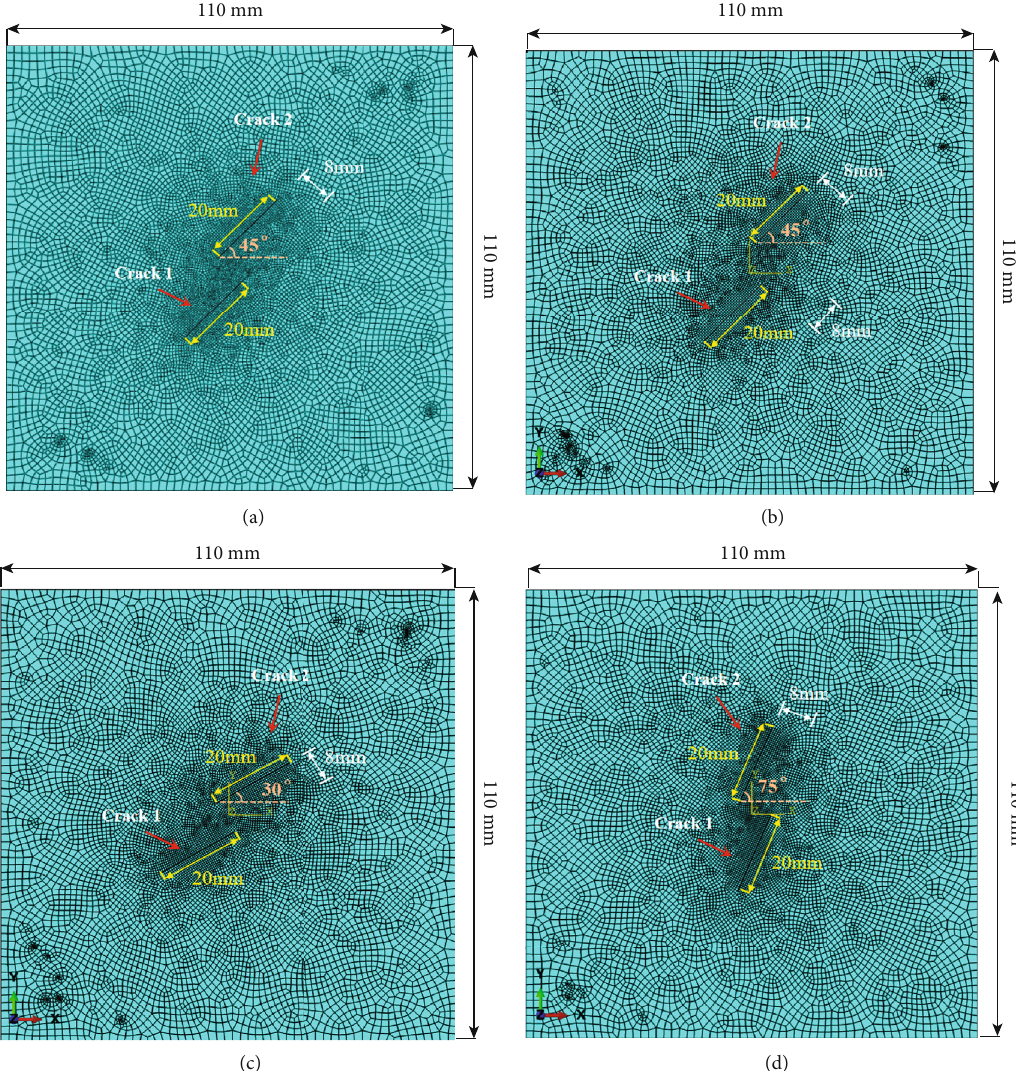
Figure 12: Numerical models. (a) Model 1. (b) Model 5. (c) Model 13. (d) Model